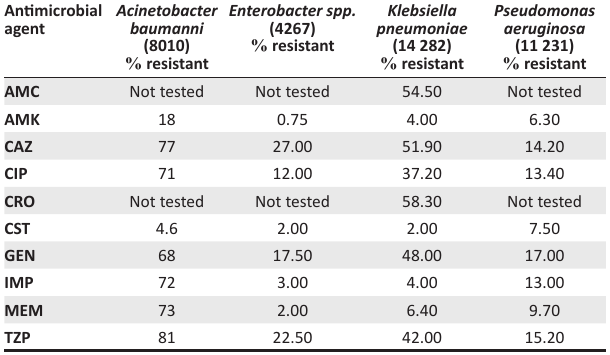
TABLE 4: Resistance profiles of Gram-negative ESKAPE pathogens (2011–2015).